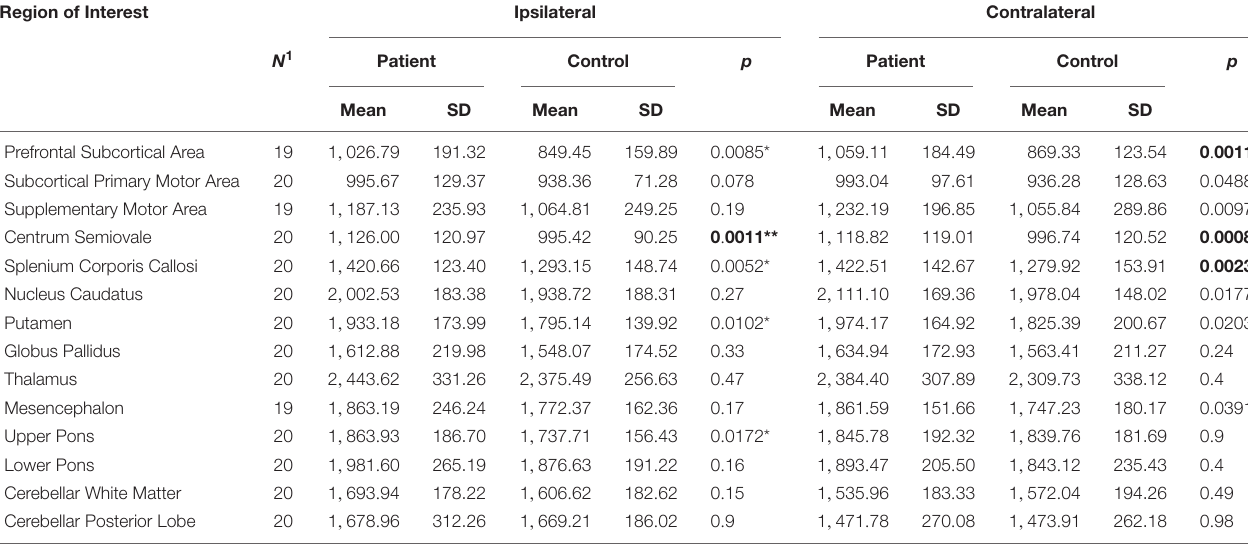
TABLE 3 | Paired t -tests between patients and controls for T1 relaxation times measured in brain hemisphere contralateral or ipsilateral to the more affected body side as indicated. Region of Interest